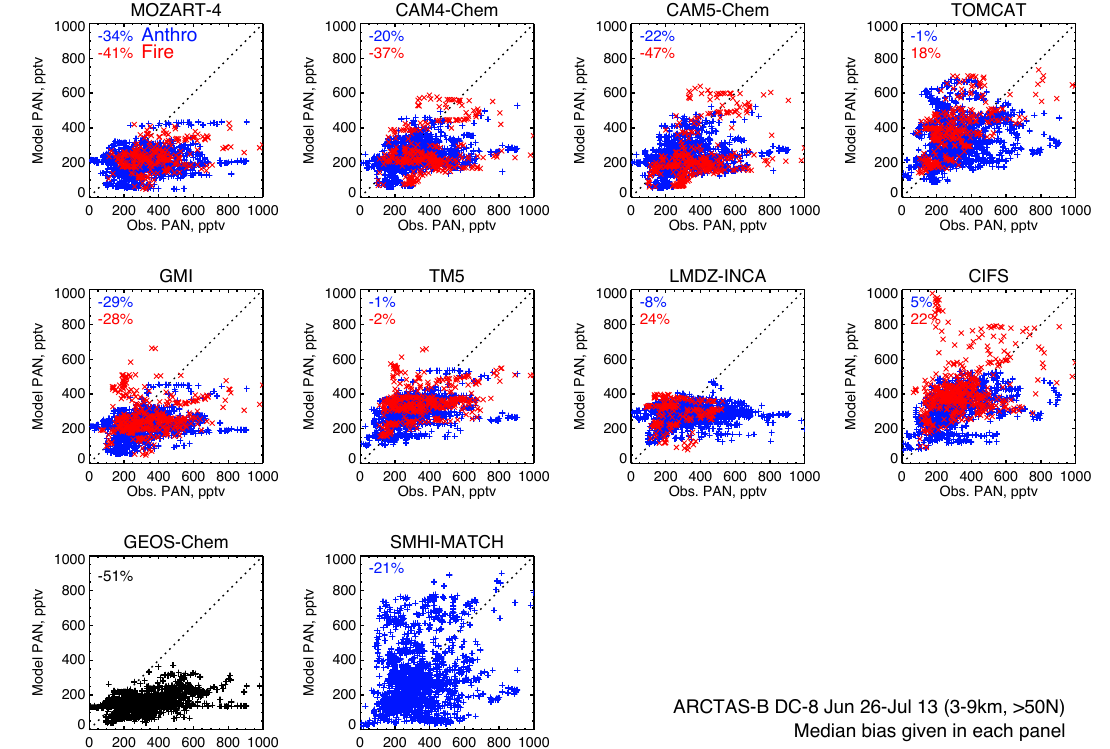
Figure 3. As Fig. 1, but for PAN.